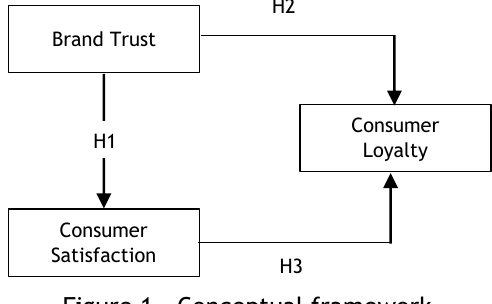
Figure 1. Conceptual